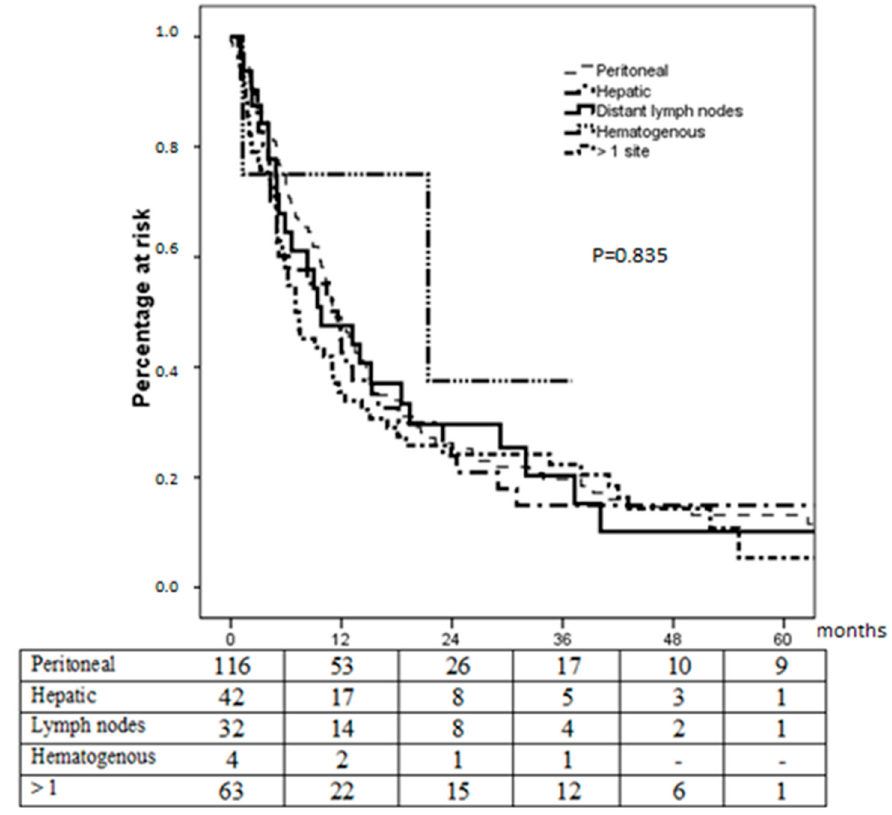
Figure 2. Survival according to metastases site.